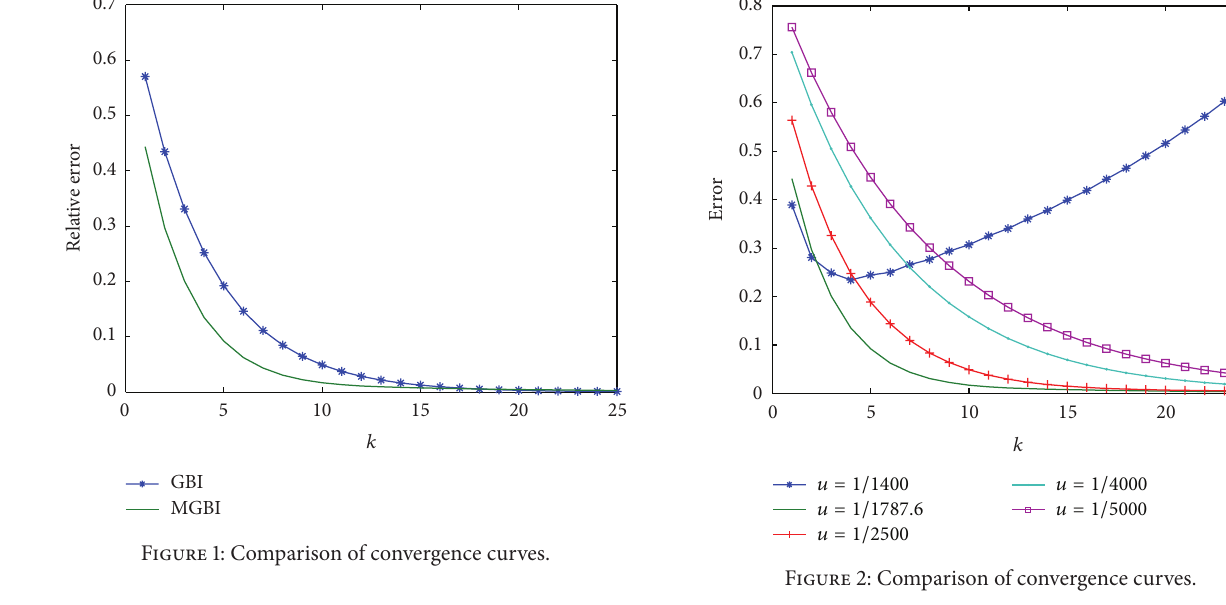
Figure 2: Comparison of convergence curves.